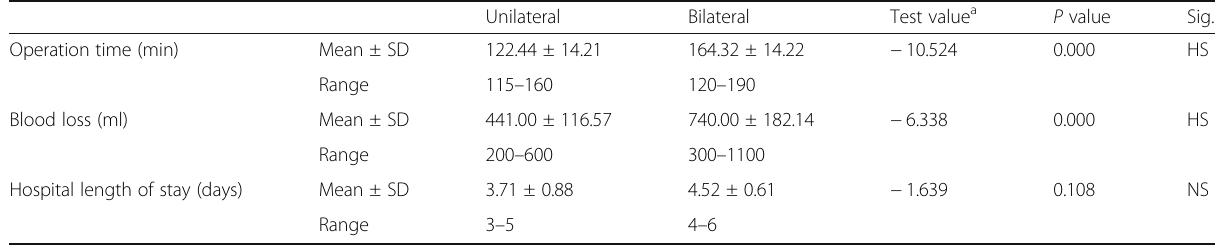
Table 4 Comparison between unilateral group and bilateral group regarding intraoperative data and hospital length of stay Unilateral Bilateral Test value a P value Sig. Operation time